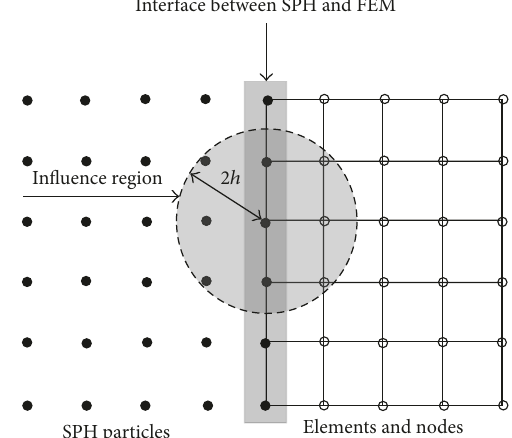
Figure 4: Interaction between SPH particles and FE (Swaddiwud- hipong et al.